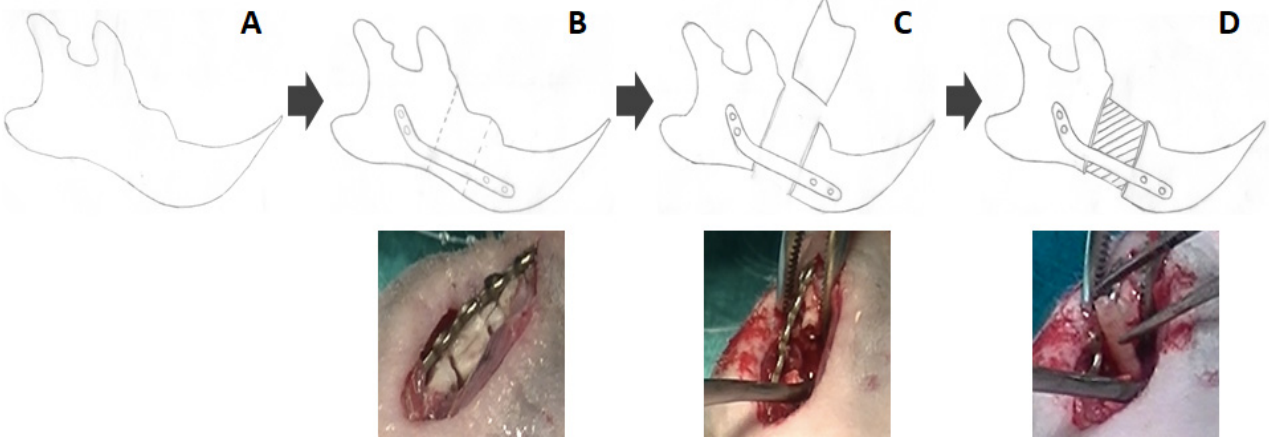
Figure 1. Generation of a severely critical-size bone defect in Foxn1rnu nude rats: ( A ) The mandibular body was surgically exposed. ( B ) A titanium microplate was fixed, and a 1-cm-long bone segment was sectioned. ( C ) The sectioned bone segment was excised. ( D ): A tissue-engineered bone substitute was implanted at the defect site.